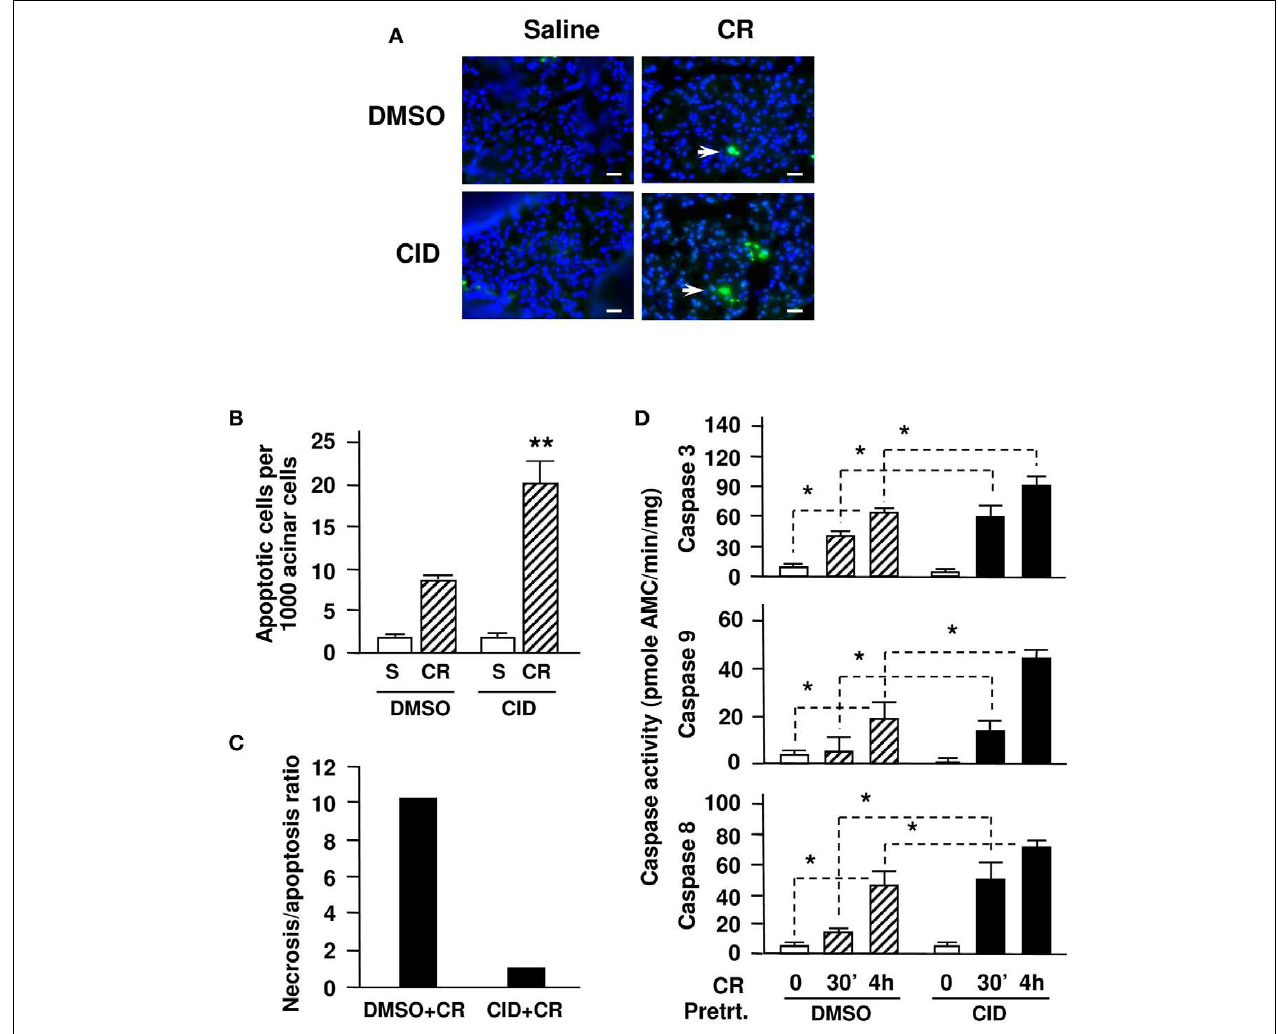
using ImageJ 1.42I software (from NIH) on pancreatic tissue sections from rats with 4h injections of cerulein (CR) and saline (S). A total of at least 2000 acinar cells were counted on tissue sections from each animal and 3–5 animals per condition were counted. (C) Necrosis/apoptosis ratios were compared in the groups of rats with and without CID pretreatment.The ratio calculation was based on the percentage of necrotic cells versus percentage of apoptotic cells using the data from (A) and Figure 4C . (D) Caspase activities at the indicated time points were measured in pancreatic tissue homogenates. Graphs (B,D) show means ± SE ( n = 3). ** P < 0.01 or * P < 0.05 versus cerulein alone without inhibitor pretreatments (CR + DMSO) or versus control without cerulein (DMSO) as